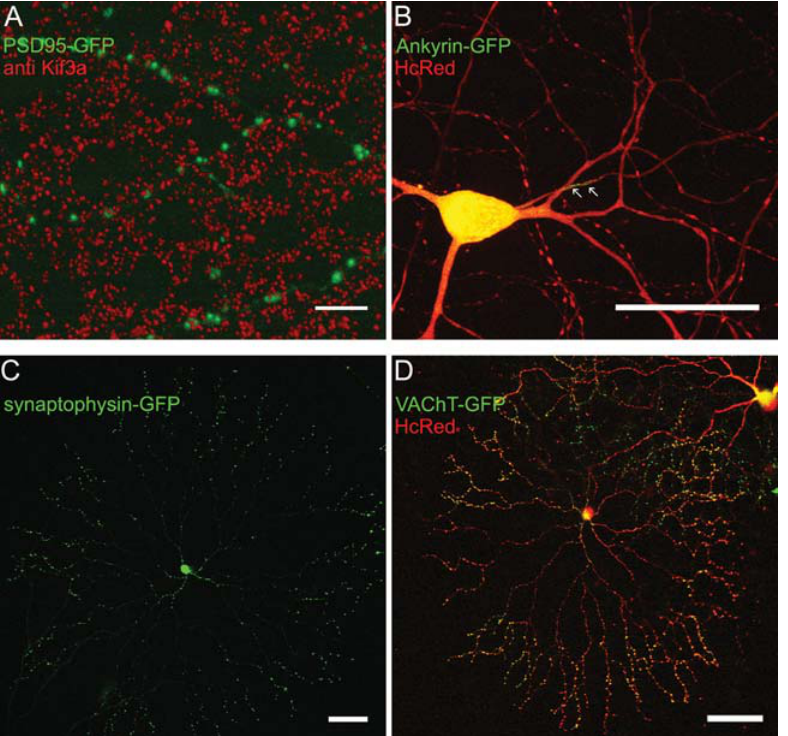
Figure 6. Pre- and postsynaptic markers and ankyrin-G are correctly localized in transfected retinal neurons. ( A ) High-power view of several dendrites of a retinal ganglion cell transfected with PSD95-GFP (green) and counterstained with an antibody against the synaptic ribbon component Kif3a (red). Most PSD95 puncta are in close proximity to one or more synaptic ribbons. Scale bar, 10 m m. ( B ) Ankyrin-G-MB-GFP (green) and HcRed (red) were transfected into a retinal ganglion cell. HcRed labels the whole extent of the cell, whereas Ankyrin-G-MB-GFP is found in the initial segment of the axon (arrows). Some Ankyrin-G-MB-GFP labeling is seen in the soma and the primary dendrites, the place of protein synthesis. Scale bar 50 m m. ( C ) Starburst amacrine cell transfected with an expression plasmid for synaptophsin-GFP. The known synaptic output sites of these cells, varicosities in the outer third of the dendritic tree are labeled with this marker. ( D ) Starburst amacrine cell transfected with expression plasmids for the cell-filling marker HcRed (red) and a fusion protein from the synaptic vesicle marker VAChT-GFP (green). Scale bar, 50 m m.